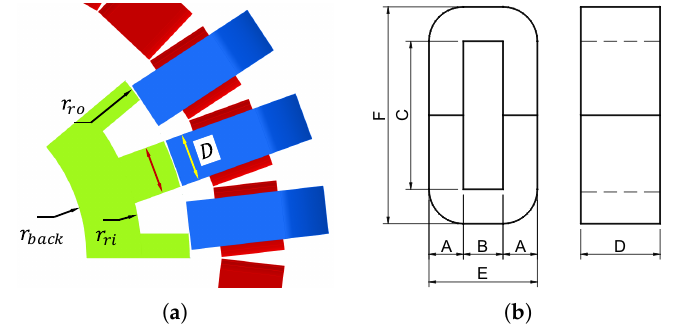
Figure 8. HM3D machine geometry; ( a ) main dimensions and ( b ) C-shaped core dimensions.